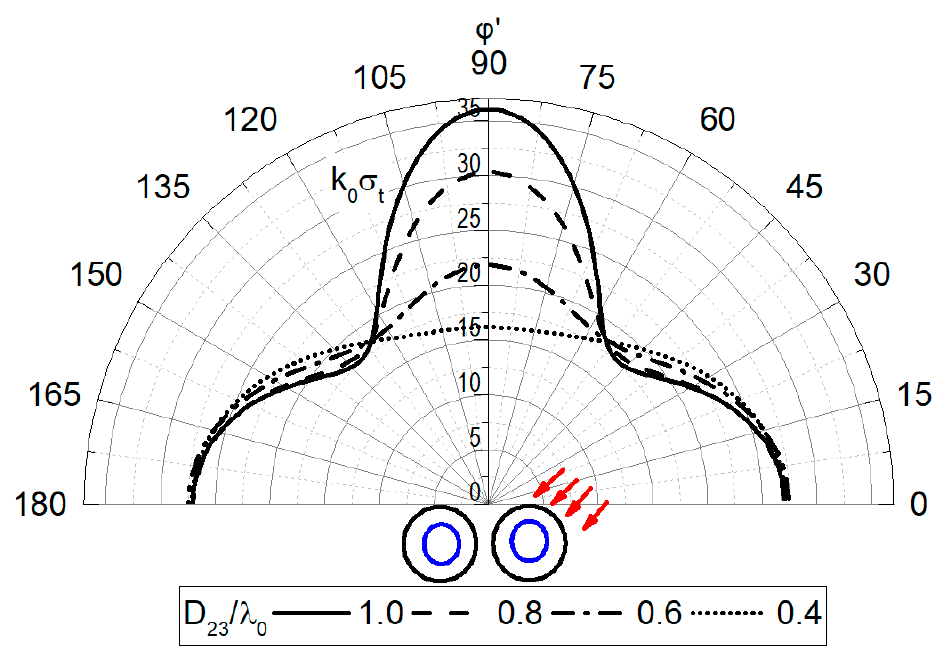
′ φ σ ) versus for the inset structure,